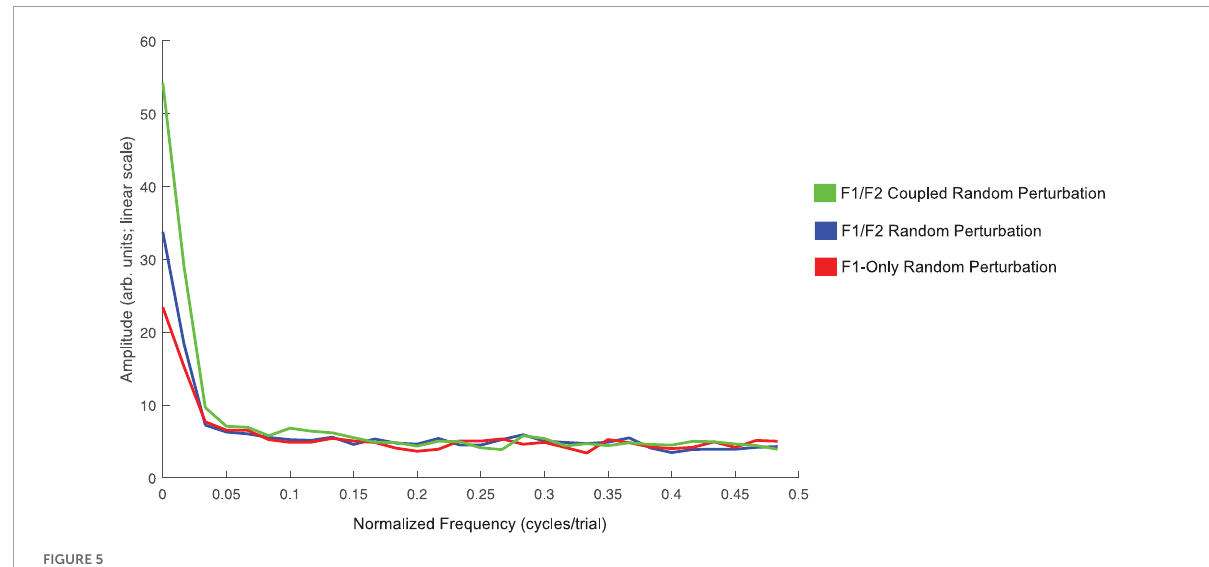
FIGURE5 Average amplitude spectra across all 18 speakers for the F1/F2 Coupled Random Perturbation Condition (green), F1/F2 Random Perturbation Condition (blue), and F1-Only Random Perturbation Condition (red) in Experiment 1. The left-most frequency bin of 0 cycles/trial represents the DC-offset. It reflects the mean change in normalized F1 values in the Perturbation phase of each condition as compared to Baseline. Instances of peaks in amplitude at higher frequencies would represent prominent oscillation of F1 values across trials in the Perturbation phase. The spectra were created using a discrete Fourier transform with a Hanning window and sampling frequency set to one sample per